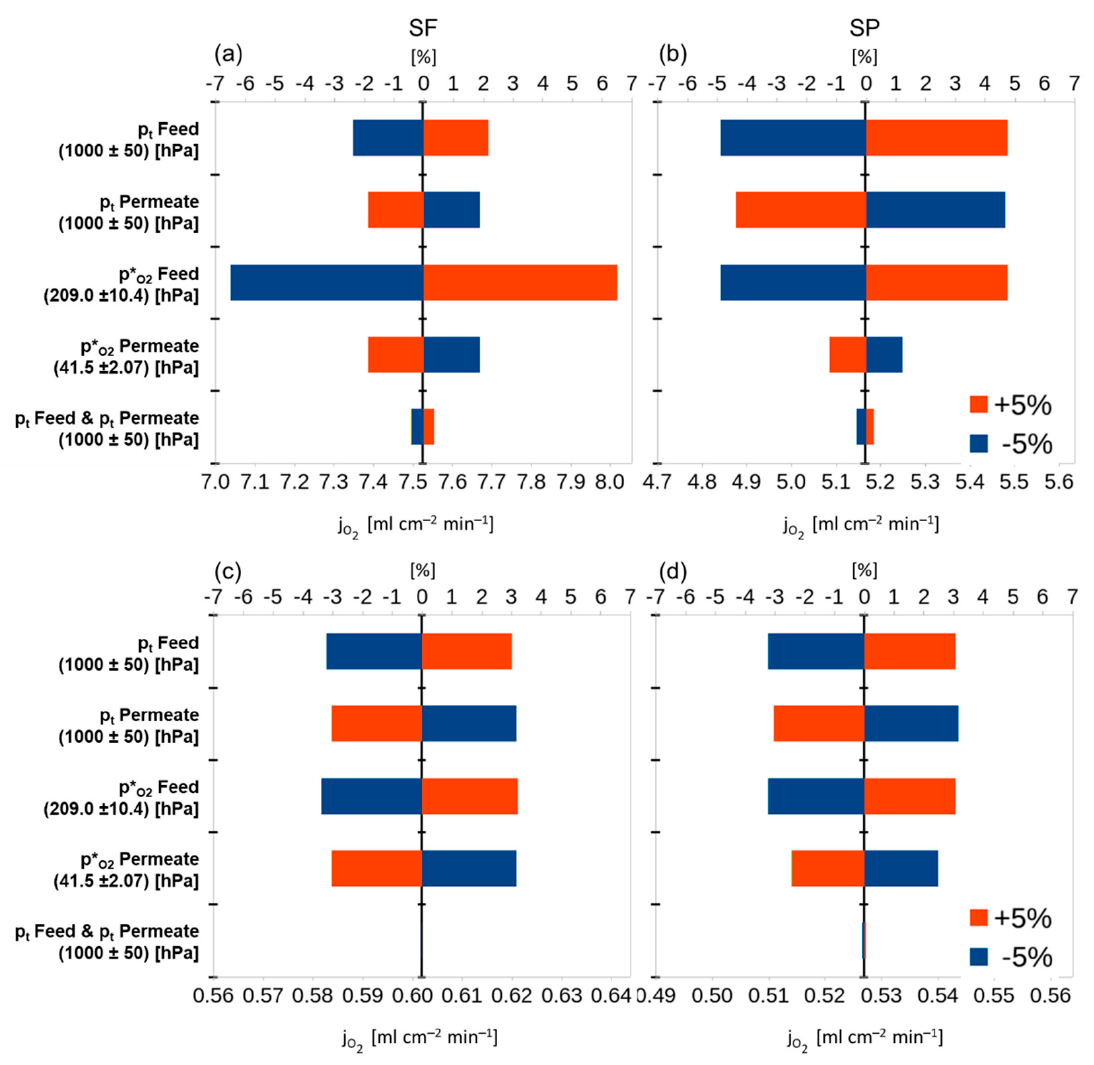
Figure 5. Detailed sensitivity study of the effect of total and partial pressures on the feed and permeate sides for BSCF ( a , b ) and STF ( c , d ).